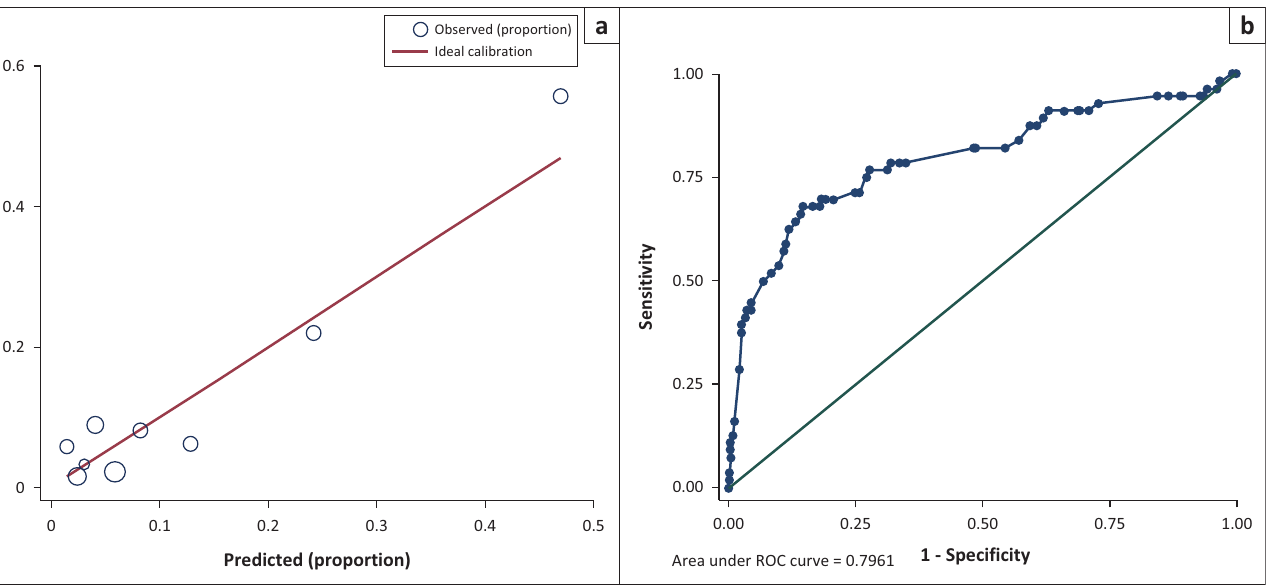
The line shows perfect calibration between observed and predicted PJP. (b) Receiver operating characteristics (ROC) of the respiratory rate model. FIGURE 1: Respiratory rate multivariable logistic regression model to establish a clinical prediction rule for the diagnosis of Pneumocystis jirovecii pneumonia (PJP) among 500 seriously ill HIV-infected participants presenting with a cough of any duration and one or more World Health Organization danger signs. (a) Calibration plot for the assessment of variables included in the respiratory rate model. (b) Receiver operating characteristics (ROC) of the respiratory model.